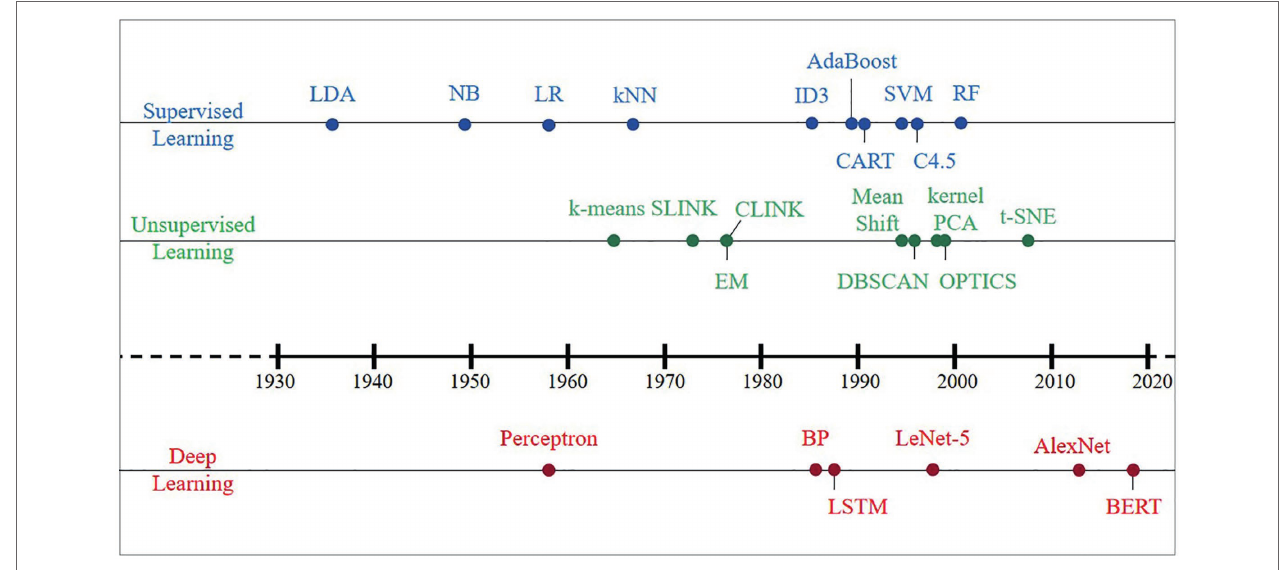
FIGURE 2 | Development history of classical machine learning algorithms since the